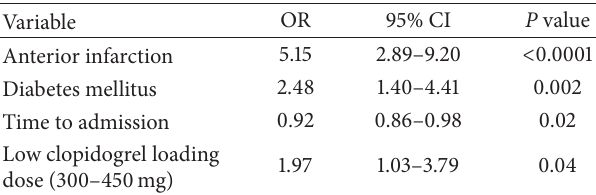
Table 5: Multiple logistic analysis of low LVEF (LVEF ≤ 50